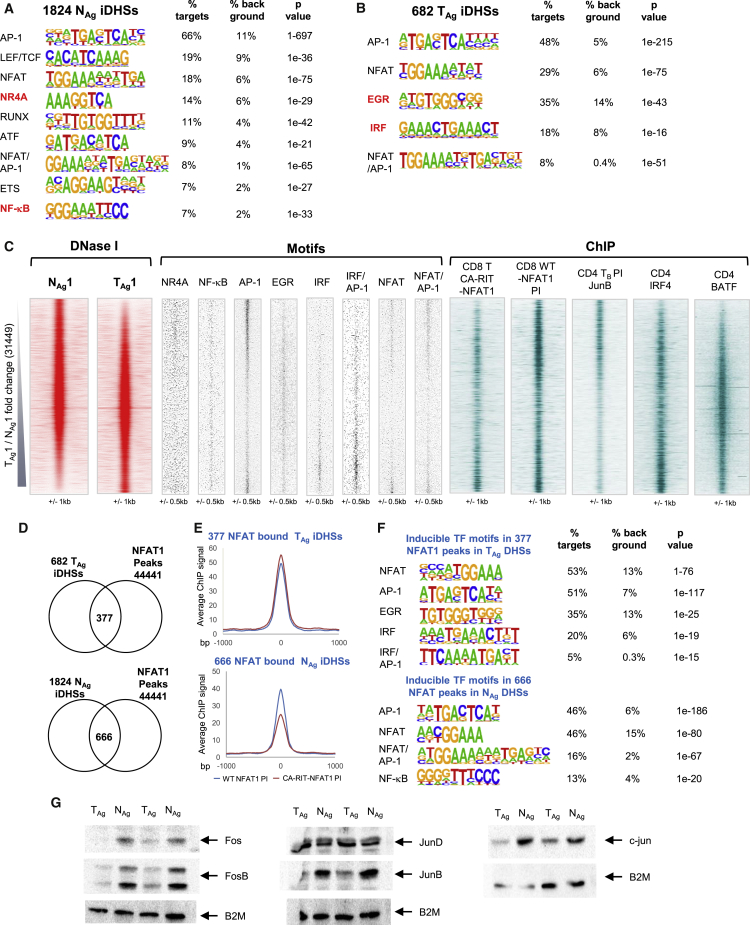
Analyses of TF Interactions with DHSs in Naive and Tolerized T Cells(A and B) Homer de novo identification of enriched TF motifs in the 1,824 NAg-specific iDHSs (A) and the 682 TAg-specific iDHSs (B).(C) Locations of transcription factor binding motifs (middle) at all DNase I peaks in the Ag-stimulated samples ordered according to the FC in sequence tag density for TAg compared with NAg (left). Aligned on the same axis are published ChIP-seq data for JunB in TB cells (Bevington et al., 2016), IRF4, BATF in CD4 T cells (Li et al., 2012) and constitutively active CA-RIT-NFAT and endogenous PI-induced NFAT in CD8 T cells (Martinez et al., 2015) (right).(D) Venn diagrams depicting the overlaps between the published data for 4,4441 peaks detected in ChIP assays for CA-RIT-NFAT1 and/or endogenous (WT) NFAT1 in PI-stimulated T cells (Martinez et al., 2015) with the 682 TAg-specific iDHSs (upper) or 1,824 NAg-specific iDHSs (lower).(E) Average ChIP-seq signal for WT NFAT1 and CA-RIT-NFAT in PI-stimulated T cells at the 377 NFAT TAg-specific iDHSs (upper) and 666 NFAT-bound NAg-specific iDHSs (lower).(F) HOMER de novo identification of inducible TF motifs within the 377 and 666 sites.(G) Representative example of western blot assays of Fos, FosB, JunB, Jun, JunD, and B2M proteins in T cells.